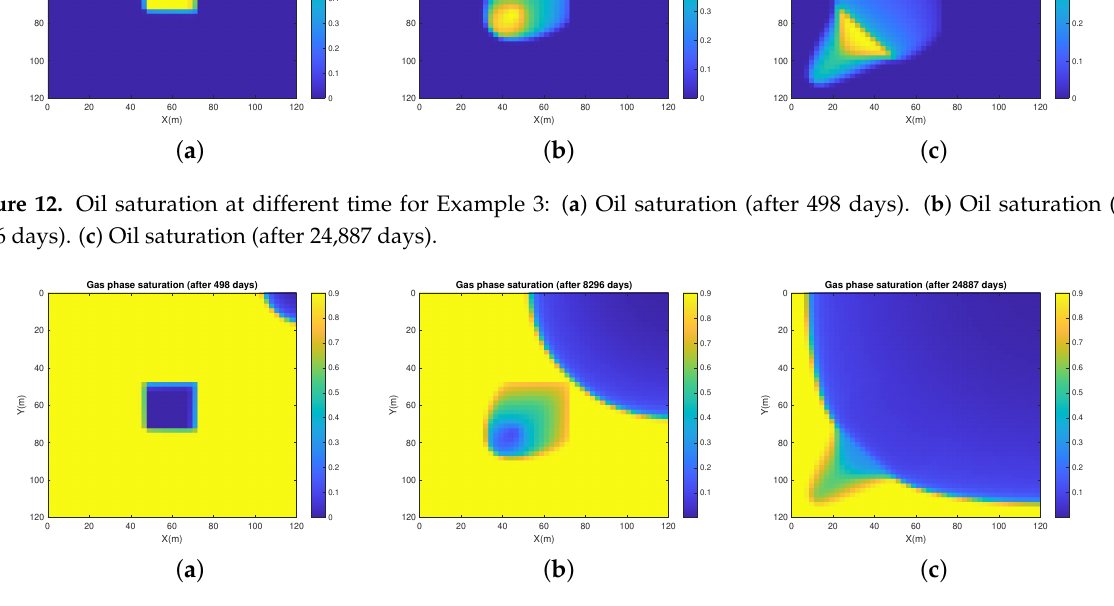
Figure 13. Gas saturation at different time for Example 3: ( a ) Gas saturation (after 498 days). ( b ) Gas saturation (after 8296 days). ( c ) Gas saturation (after 24,887 days).